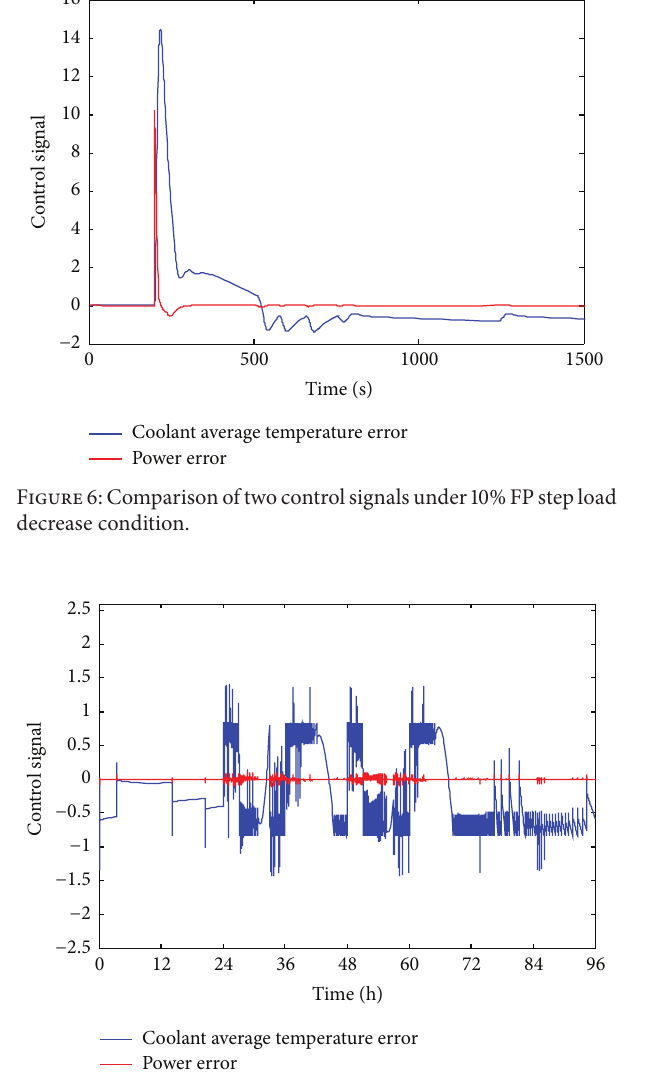
Figure 7: Comparison of two control signals under load follow con-